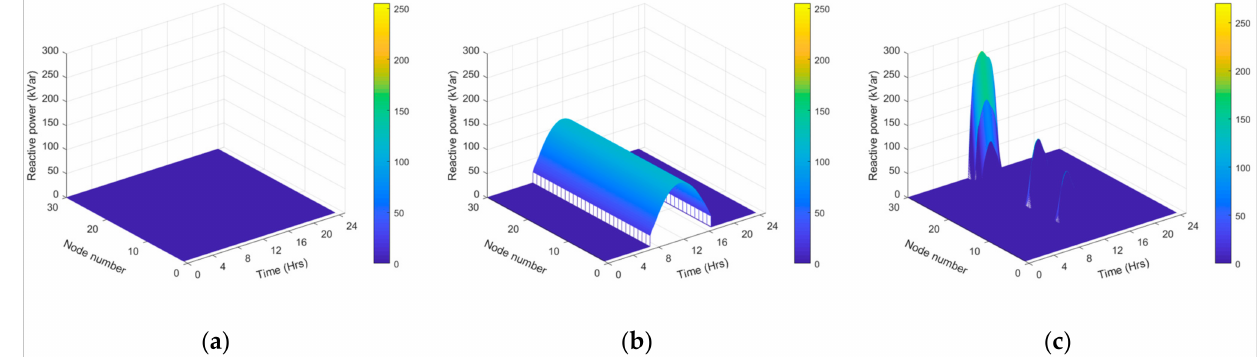
Figure 10. Daily reactive power absorption with the ( a ) Volt–Watt, ( b ) Fixed power factor, and ( c ) Volt–Var controls.